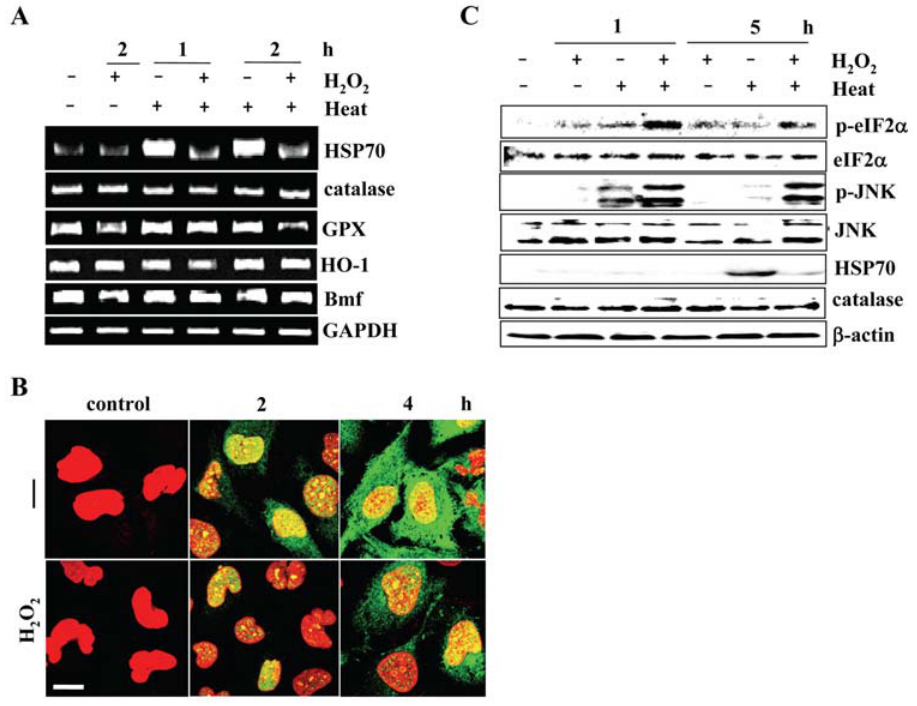
Figure 2. Effects of H 2 O 2 on HSR and expression of scavenger enzymes. A ) Total RNA was harvested from T98G cells at the indicated hours after the indicated treatments (44 u c for 20 min and/or 0.25 mM H 2 O 2 ) and transcripts of the indicated genes were evaluated by RT-PCR. B ) Confocal microscopical detection of HSP70. Cells were pretreated with 0.25 mM H 2 O 2 (H 2 O 2 ) or untreated (control) and fixed at 2 or 4 h after heat exposure. HSP70 expression was immuunohistochemically detected using the anti-HSP70 antibody and cells were counter-stained with propidium iodide (PI). Bar indicates 10 m m. C ) eIF2 a and JNK phosphorylation. At 1 and 5 h after indicated treatments as described above, eIF2 a and JNK activities were evaluated by western blots using anti-phosphorylated eIF2 a and anti-phosphorylated JNK antibodies, respectively. HSP70 and catalase expression levels were also evaluated. Anti- b -actin, anti-eIF2 a and anti-JNK protein antibodies show equal loading of protein samples.